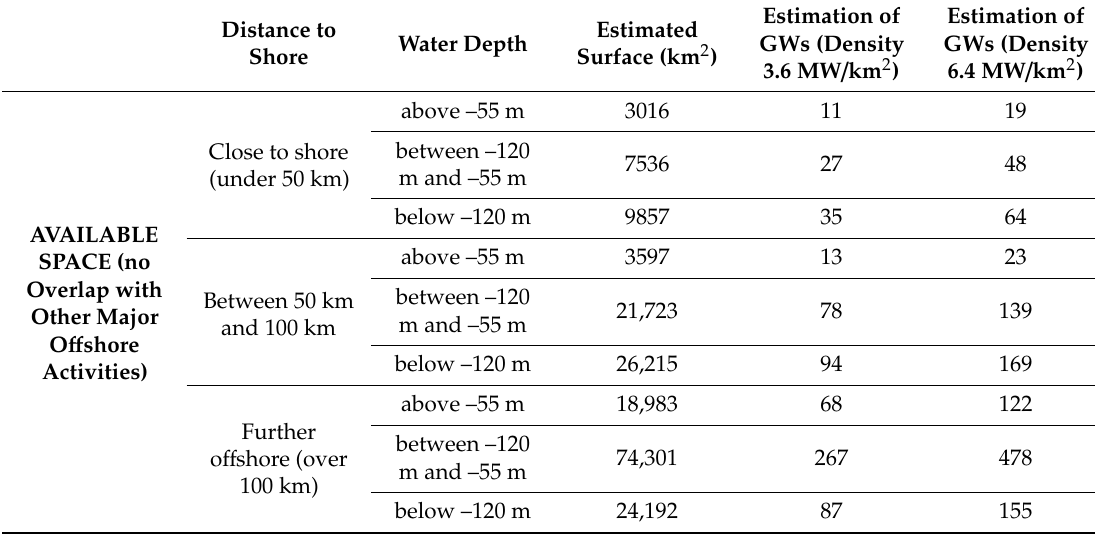
Table 11. Available space—Scenario